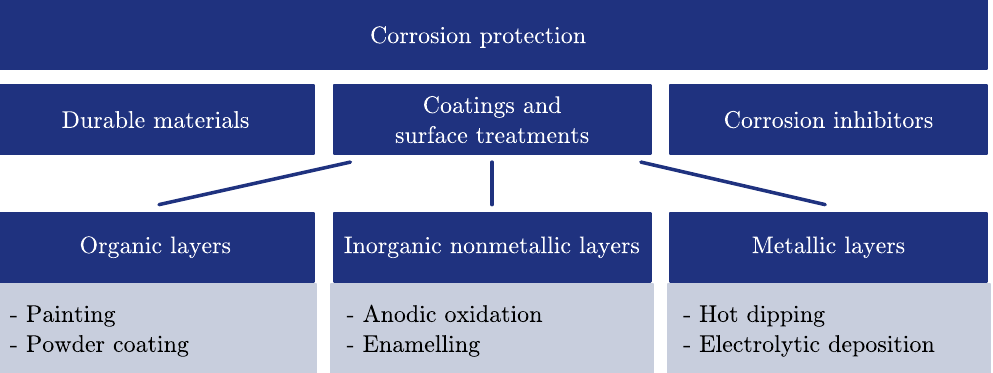
Figure 2. Summary of different corrosion protection methods which can be applied to macro- encapsulated phase-change